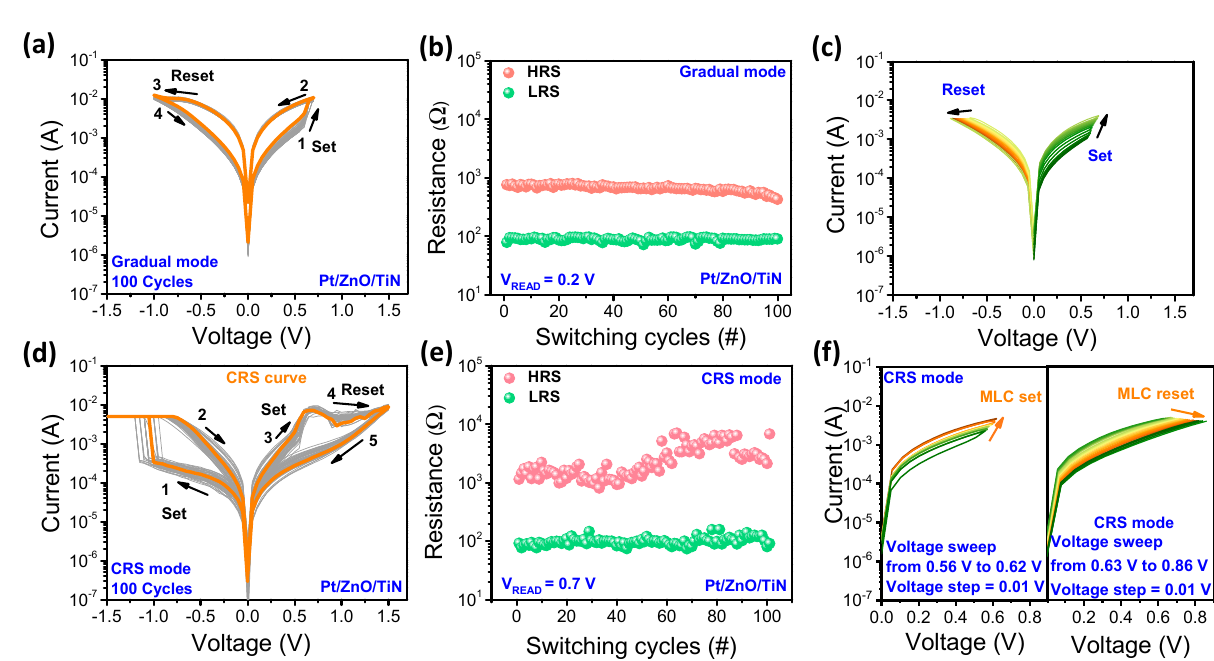
Figure 2. Gradual set and reset bipolar mode of the Pt/ZnO/TiN device. ( a ) Typical CC-free I–V curve (100 consecutive cycles). ( b ) Endurance according to the I–V data. ( c ) Multilevel switching of set and reset with gradually increasing and decreasing behavior. ( d ) I–V curves for 100 consecutive cycles with CC of 5 mA. ( e ) Endurance of the CRS mode. ( f ) Mul- tilevel switching by increasing and decreasing behavior of CRS in the positive bias region.